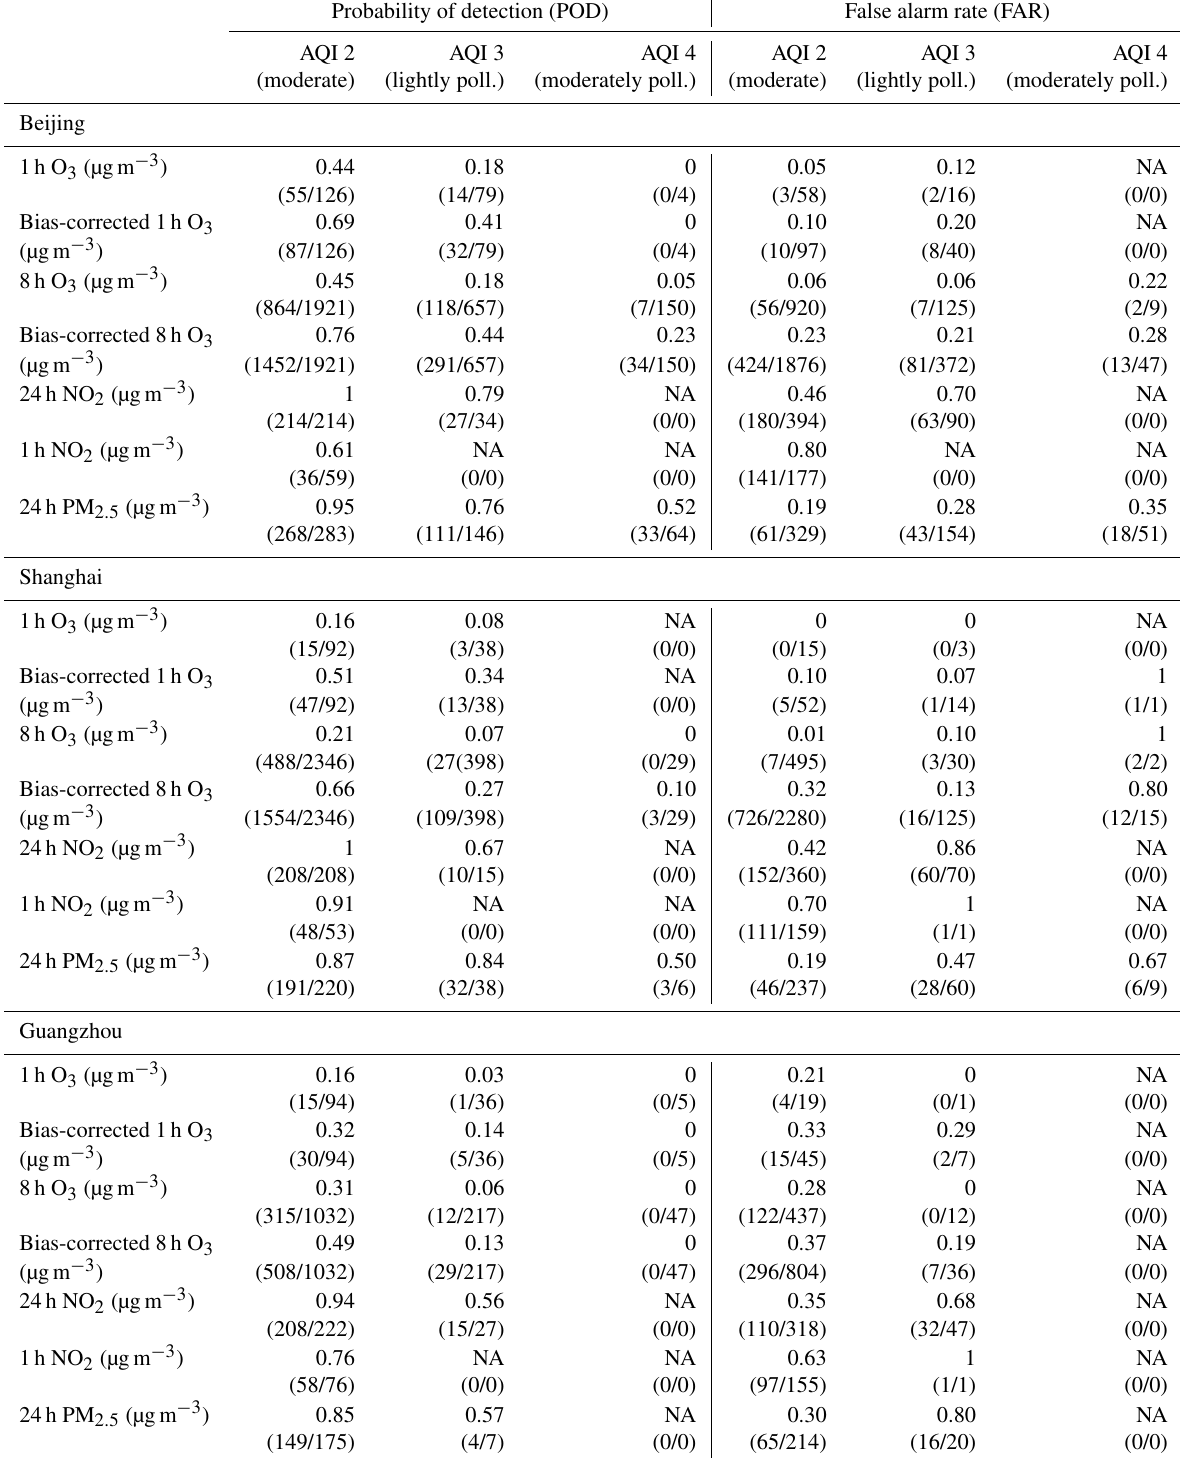
Table 3. POD and FAR for Beijing, Shanghai, and Guangzhou. Probability of detection